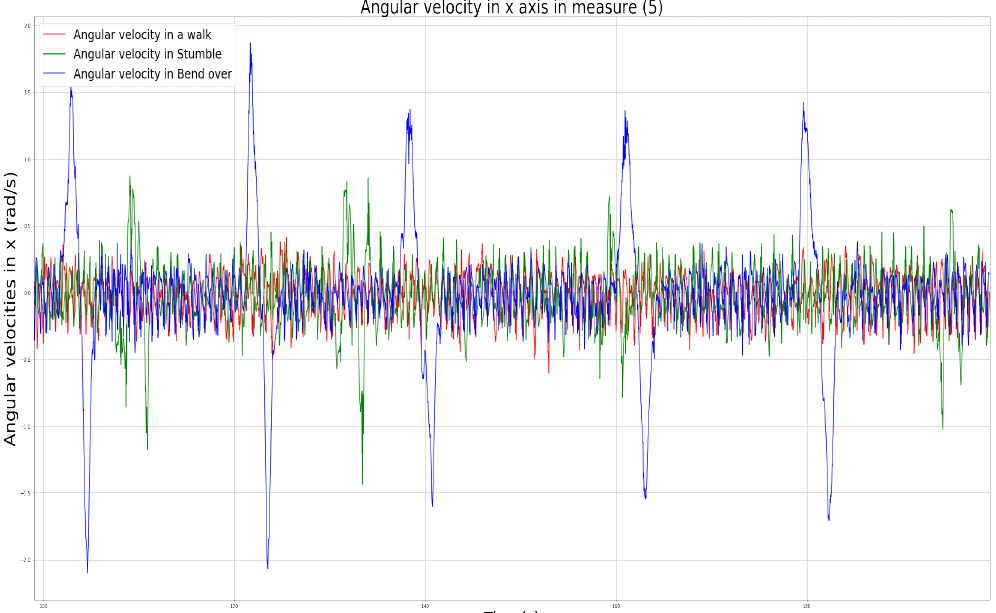
Figure 2. Differences between walking, stumbling, and bending over.